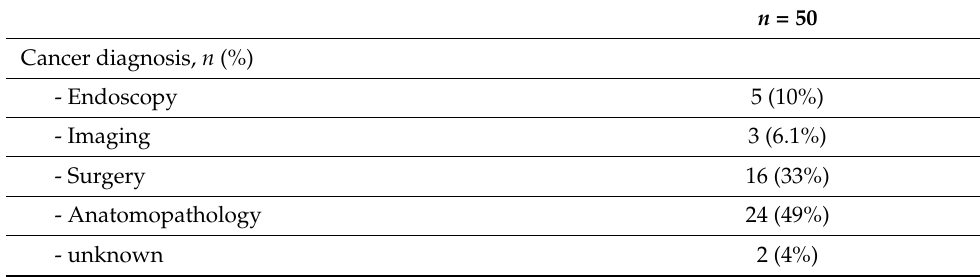
Table 4. Oncological details, management, and outcomes in the SBN